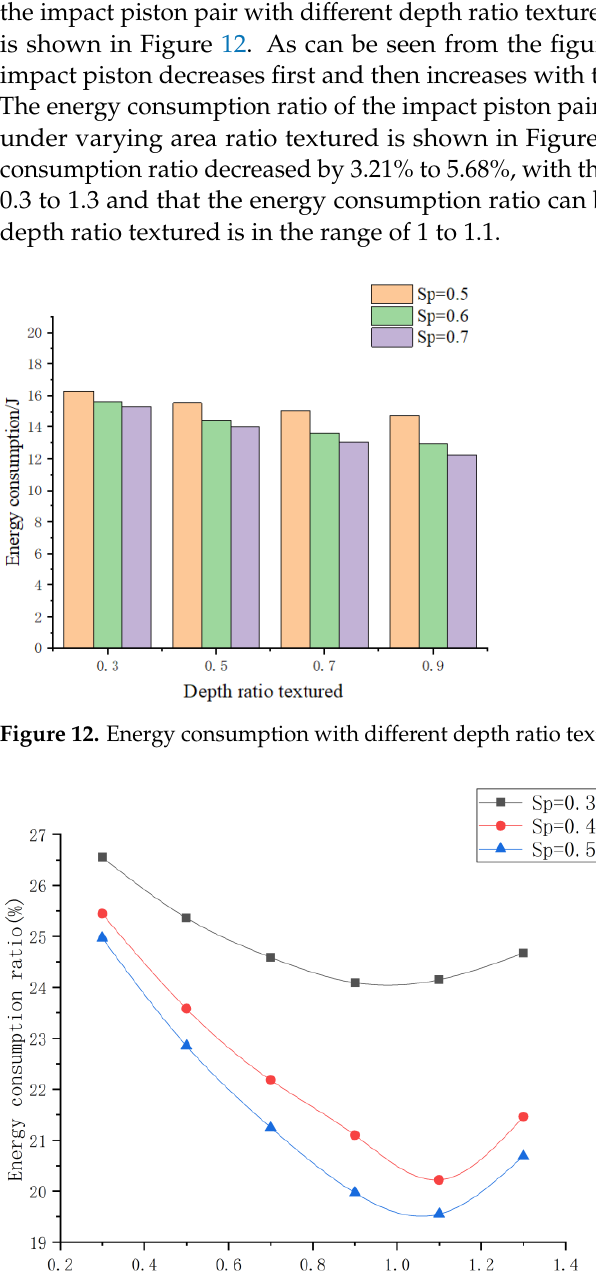
Table 4. Energy consumption and its ratio in one cycle with different depth ratio textured when area ratio textured is 0.5.